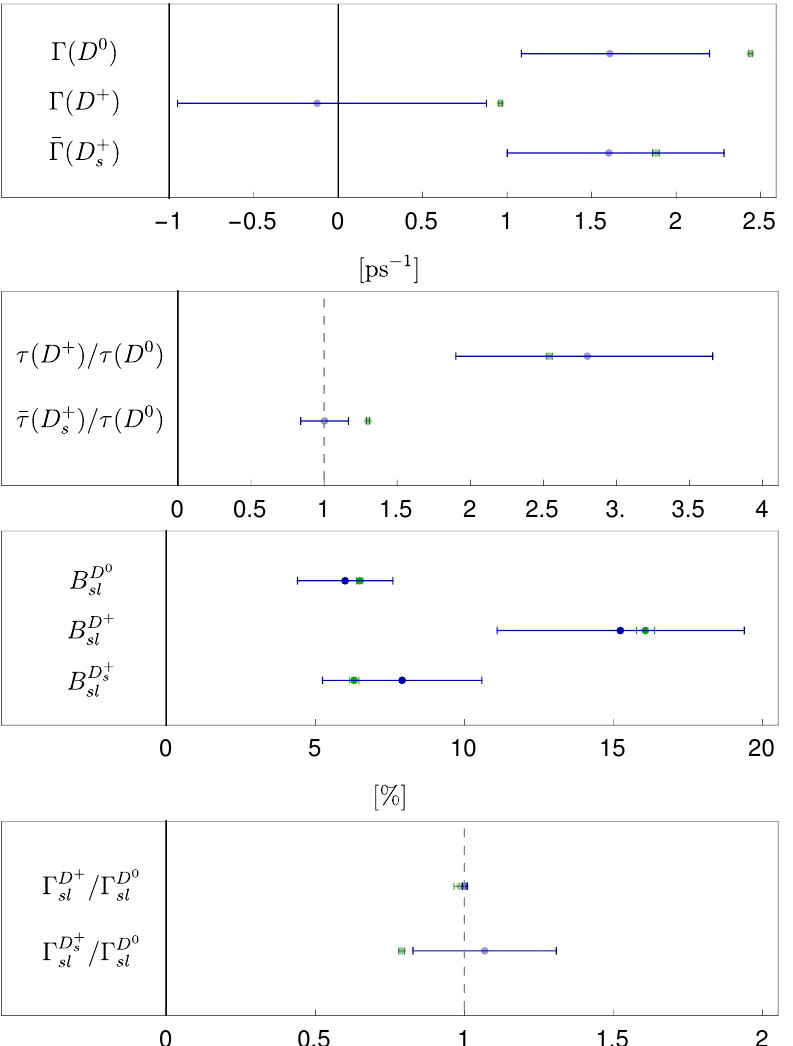
Figure 7 . A comparison of the HQE prediction for the charm observables in the kinetic scheme (blue) with the corresponding experimental data